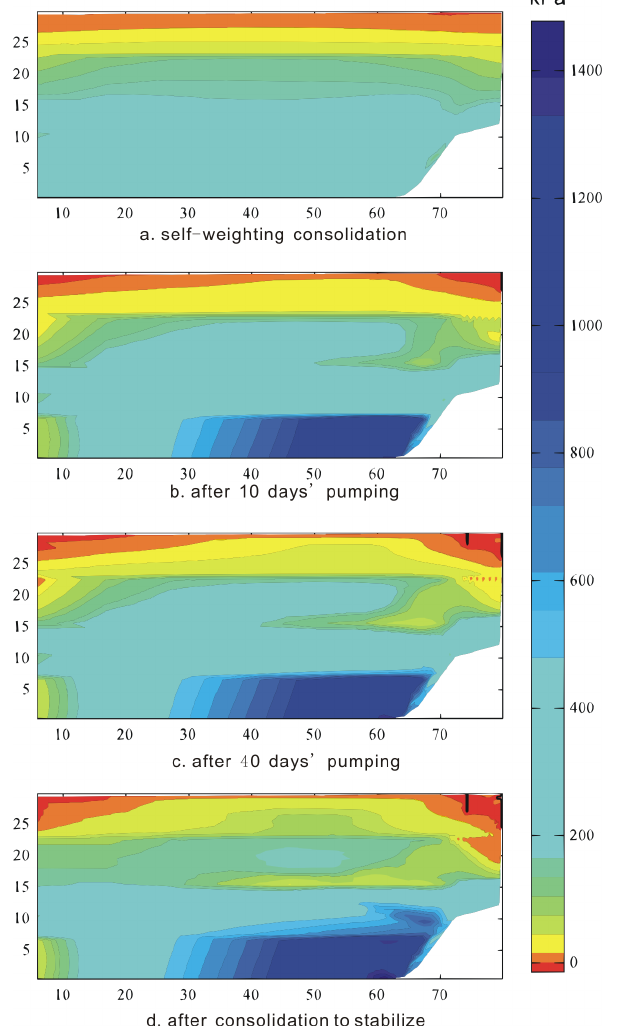
Figure 4. Distribution of minor principal stress during